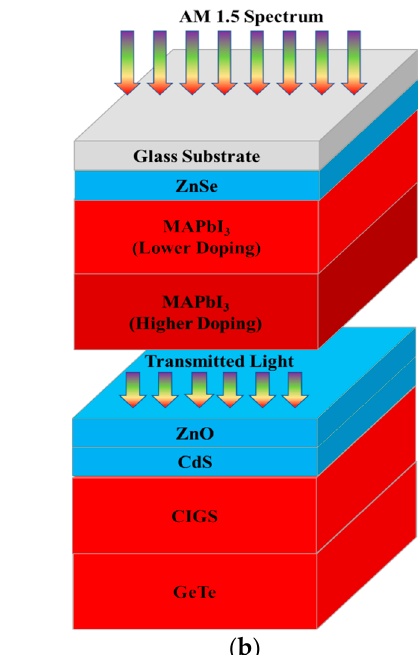
Table 1. Key incident and transmitted spectrum parameters.